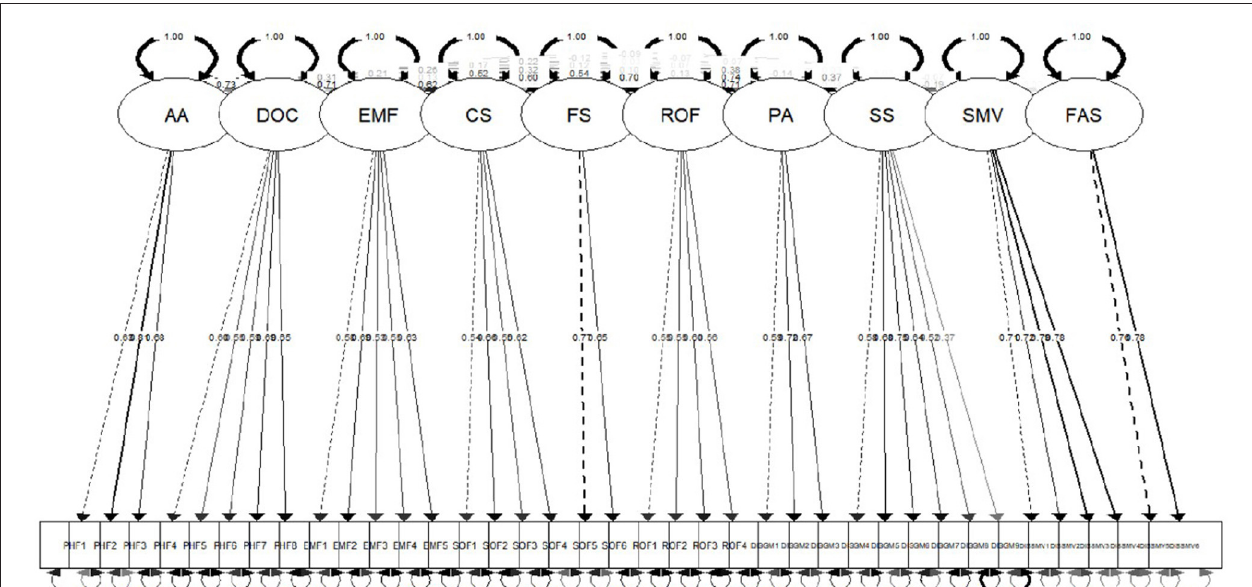
FIGURE 2 | The confirmatory factor analysis of the Quality of Life Scale for Children with Visual Impairments.